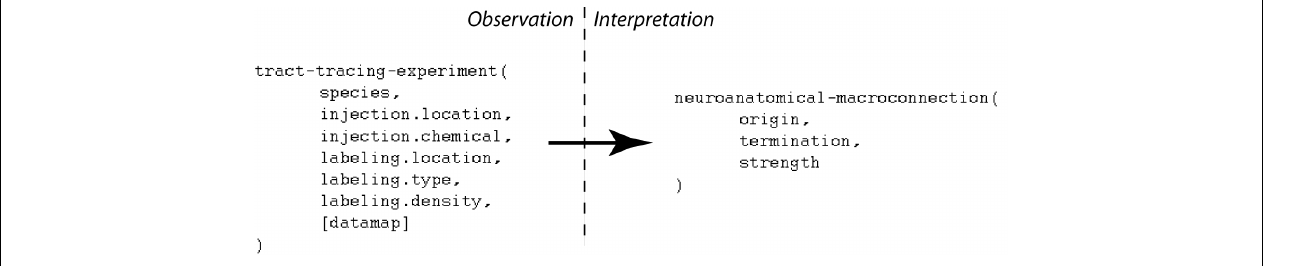
FIGURE 1 |A simplified view illustrating how a small number of variables contributing to the primary observations of a tract-tracing experiment map to the variables supporting an interpretive assertion